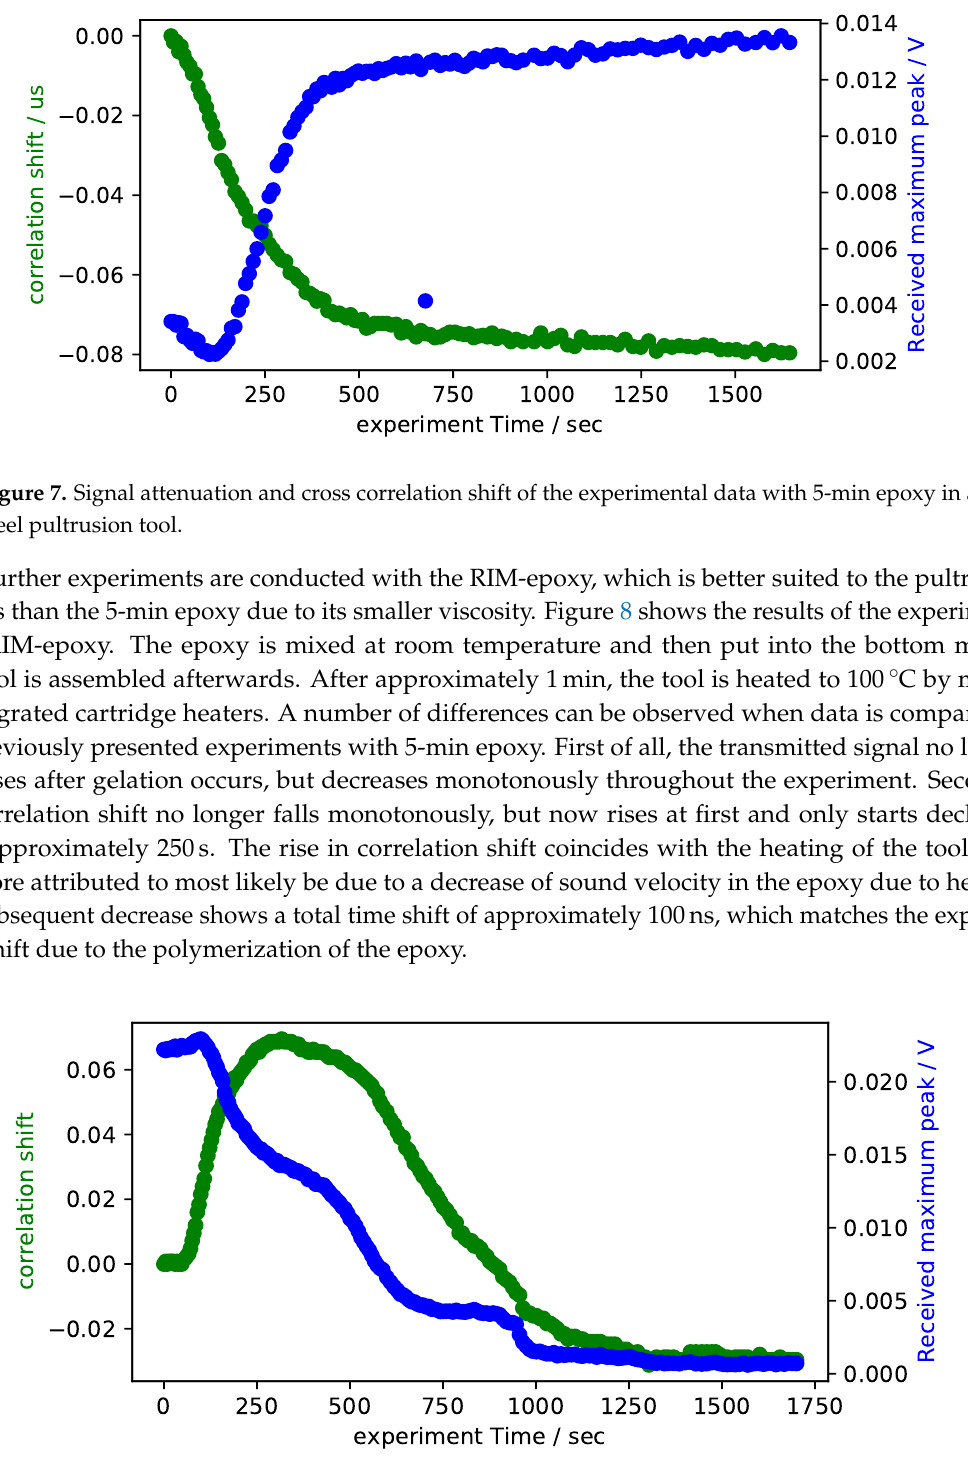
Figure 8. Signal attenuation and cross correlation shift of the experimental data with RIM-epoxy in a steel pultrusion